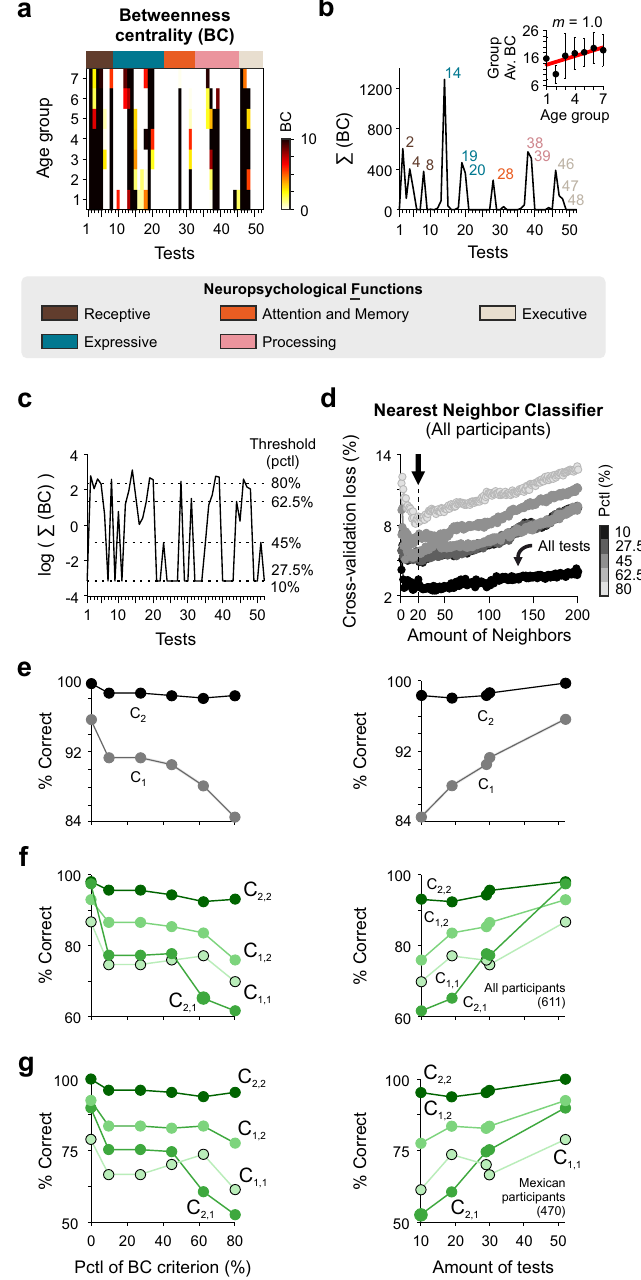
Figure 5. Supervised classification with centrality measures. ( a ) Colormap illustrating the betweenness centrality (BC) for each task as a function of age group. Binary BC was computed by thresholding each normalized correlation matrix against 0.5. Colorbar on the right. Summed BC (across ages) for the different tests in linear ( b ) and logarithmic ( c ) scales, respectively. ( d ) Cross-validation loss of a k-nearest neighbor (KNN) classifier as a function of the number of neighbors. Predictors consisted of the different tests associated with the different threshold values for BC. Optimal number of neighbors is around 20. ( e–g ) Performance of the KNN classifier as a function of the %BC criterion (left column), and as a function of the number of tests that correspond to that BC criterion (right column). The panels display the performance in classifying the children from the two main clusters for the entire dataset ( e ), the four sub-clusters for the entire group ( f ), and the four sub-clusters for the Mexican children only ( g ). Number of participants in